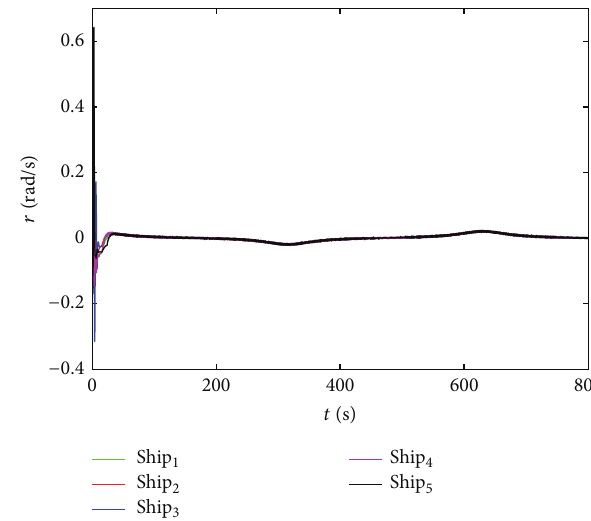
Figure 6: The heave velocity curve of each